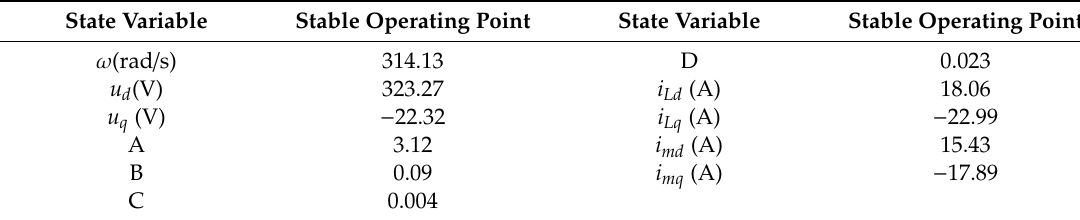
Table 1. Stable operation points of the systems.